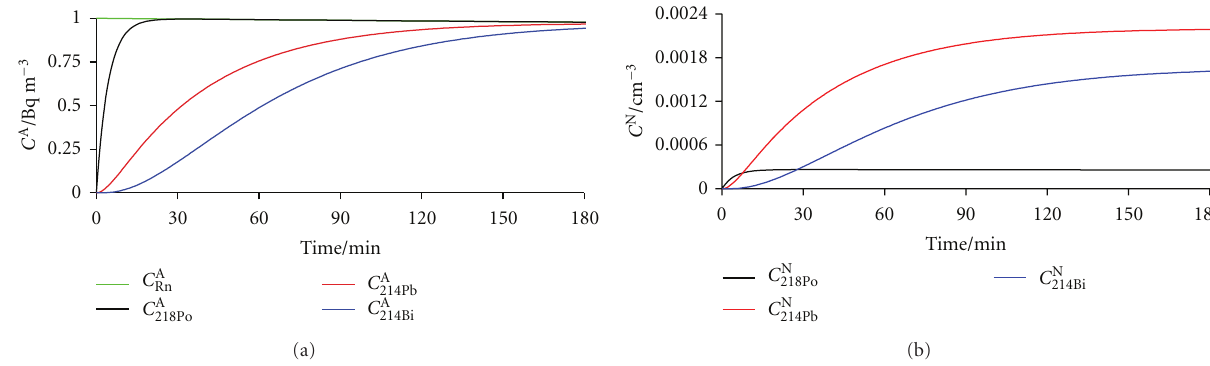
Figure 23: Growth of 218 Po, 214 Pb, 214 Bi, and 214 Po initiated by α -transformation of 222 Rn (initial activity concentration of 1Bqm − 3 , equivalent to 0.477 radon atoms cm − 3 ), expressed in: (a) activity concentration and (b) number concentration of RnDP atoms.